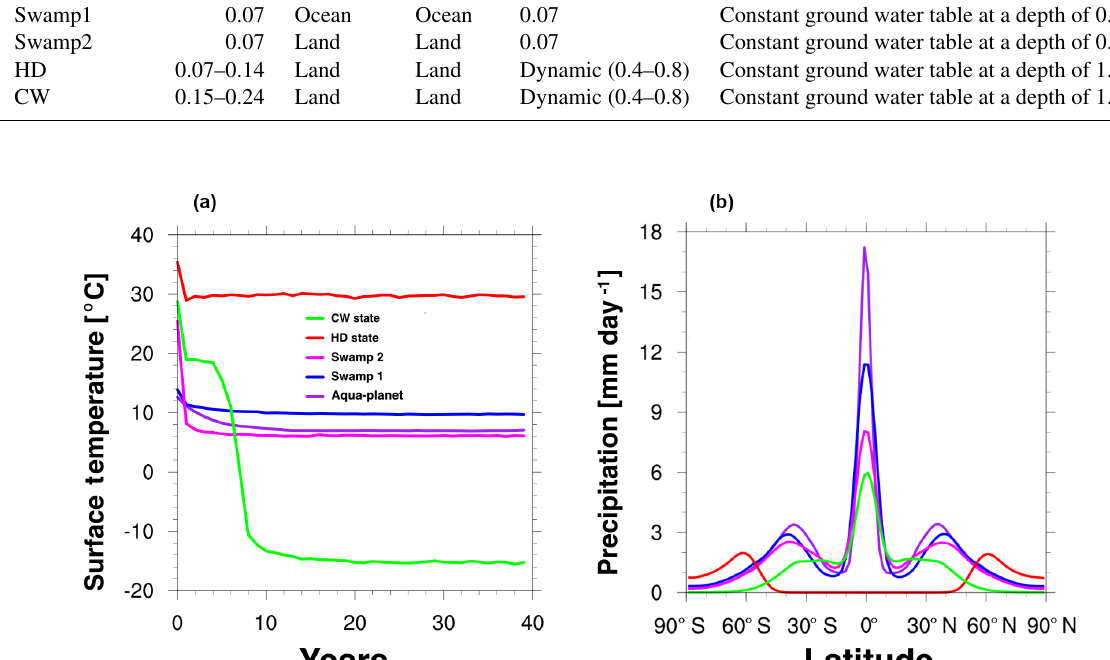
Figure A1. (a) Time series of global mean surface temperature ( ◦ C) and (b) annual mean meridional profile of precipitation (mmday − 1 ) for different simulations performed to illustrate the procedure by which we found bistability on our